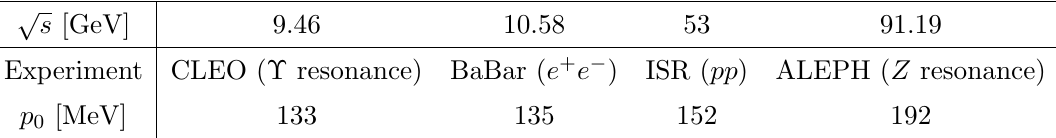
Table 1. Coalescence momenta for antideuteron formation as (cid:12)t using Pythia 8 from experimental data. Taken from [34,